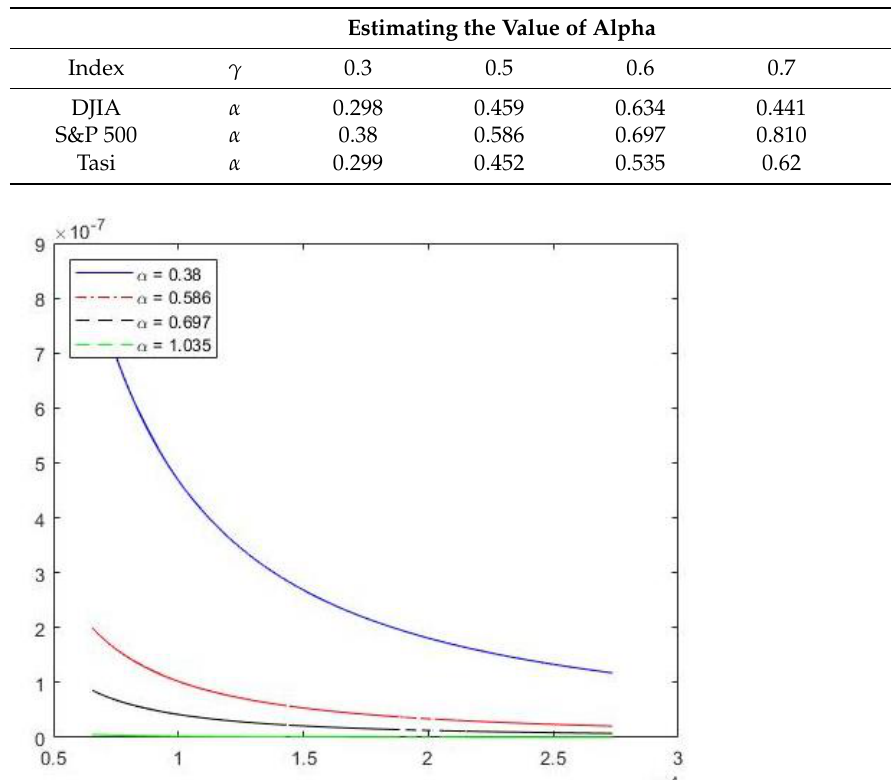
Table 1. Estimating the value of α at various γ values in the range ( 0,1 ) while fitting to real market data (DJIA, S & P 500, and TASI).